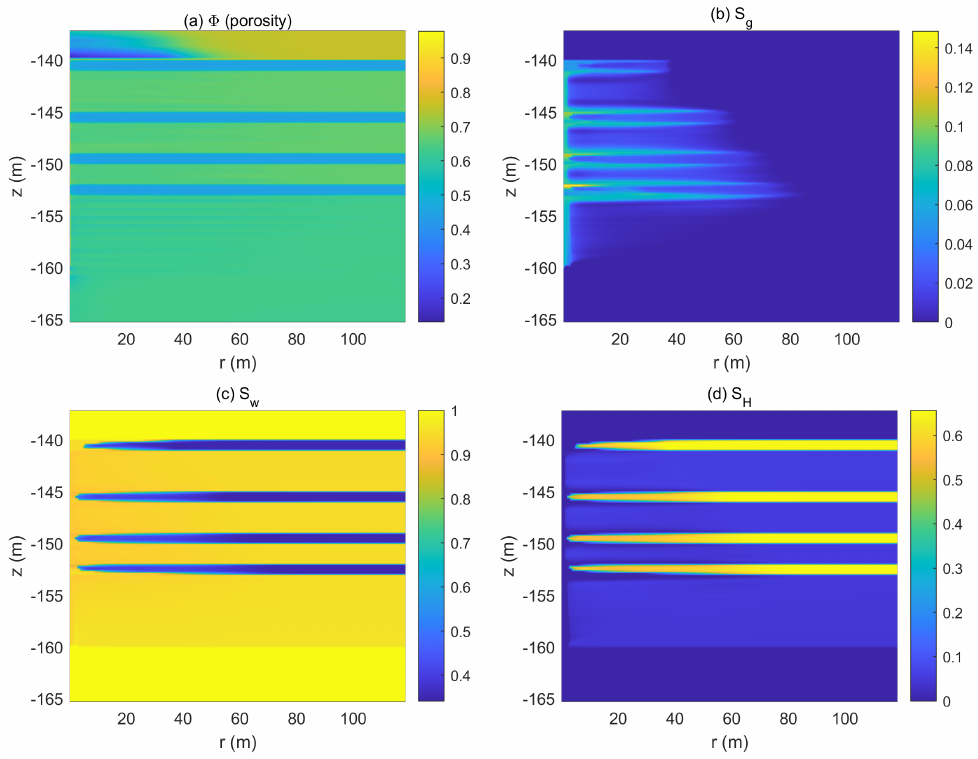
Figure 5. Porosity and saturations of gas, water, and hydrate on day 0 (the initial state).